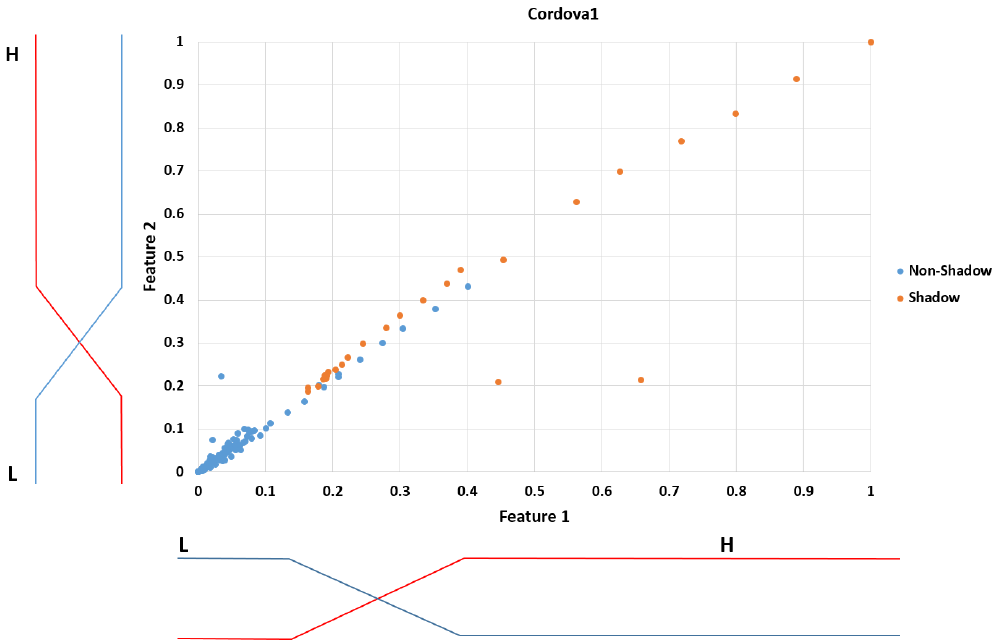
Figure 9. Input fuzzy membership functions for features 1 and 2, which are designed by maximum entropy criterion with training data.